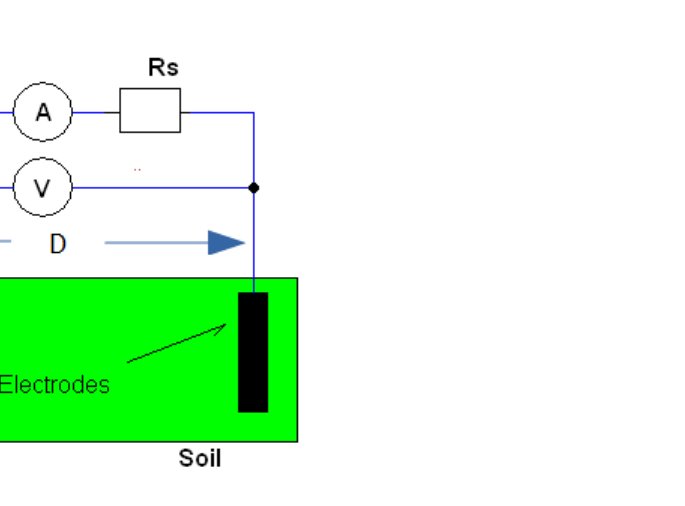
Figure 1. The electrical soil resistivity setup for the 2-electrode method. R s is the internal resistance of the voltage source.